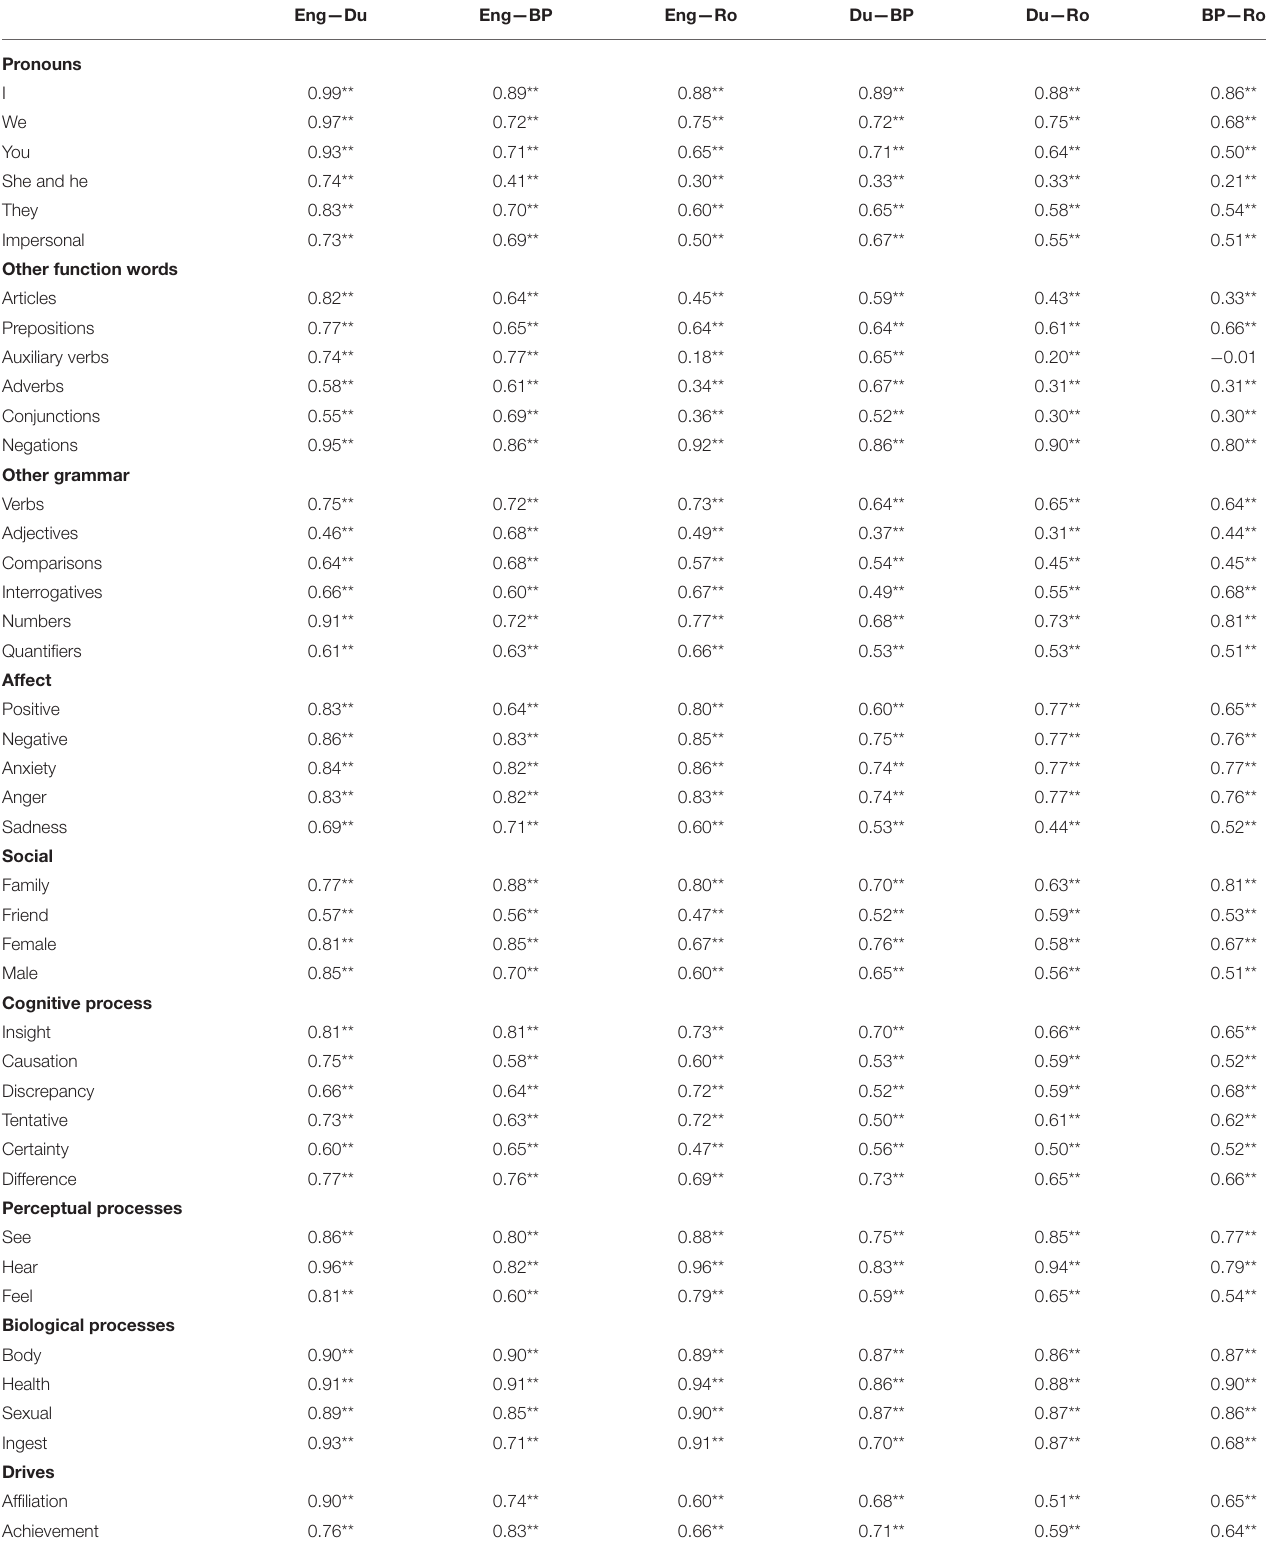
TABLE 1 | Pearson’s correlation coefficients for the word percentages obtained with the four LIWC2015 dictionaries. Eng—Du Eng—BP Eng—Ro Du—BP Du—Ro